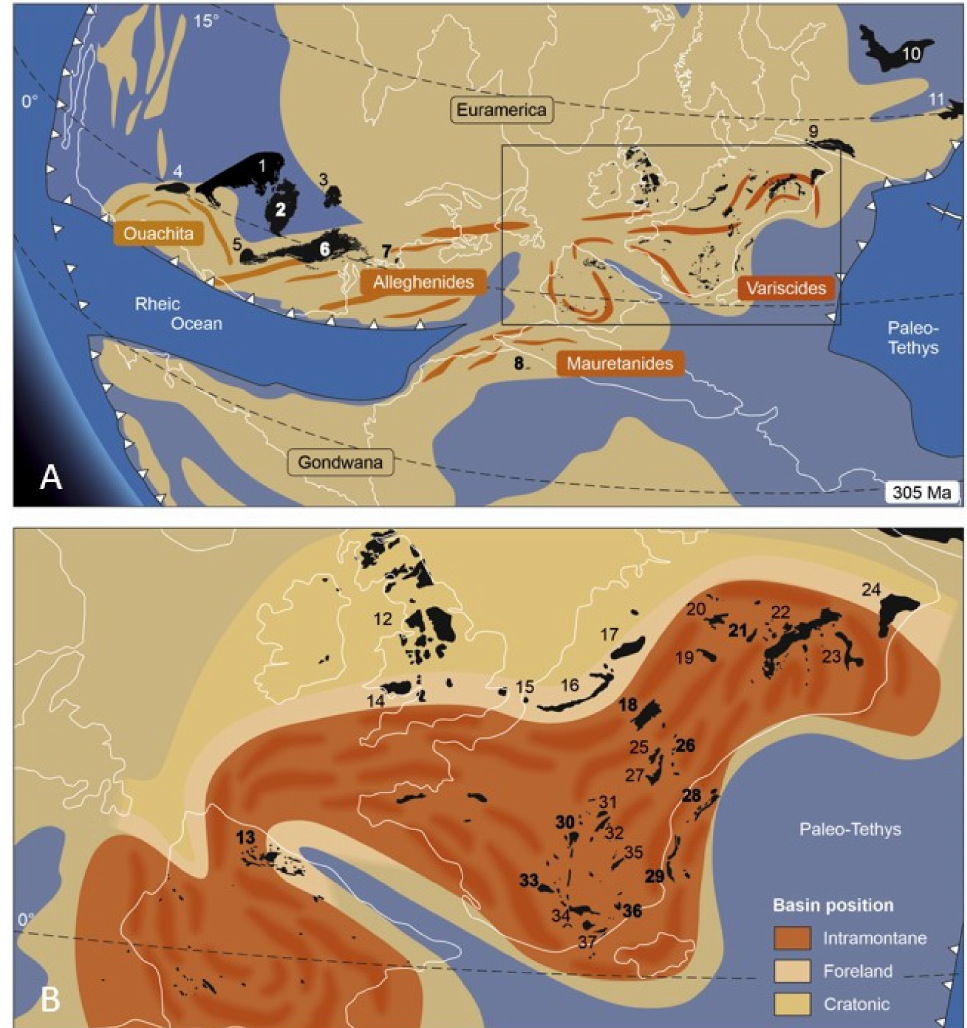
Figure 2. Late Carboniferous, Moscovian to Gzhelian, Euramerican orogenic belts and basins: ( A )—basins from the North American Midland Basin in the west to the Donetsk Basin in the east; ( B )—details of ( A ) with the European basins. Furthermore: 1 Western Interior Basin, 2 Illinois B., 3 Michigan B., 4 Midland B., 5 Black Warrior B., 6 Appalachian B., 7 Narragansett B., 8 Souss